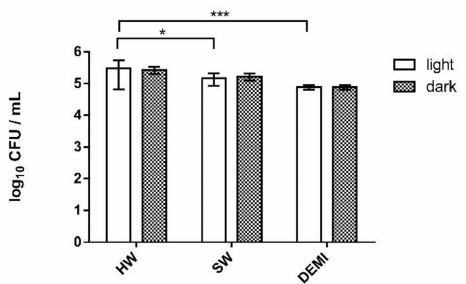
Figure 12. Impact of water hardness (HW, SW, and DEMI) and violet light irradiation on L. pneumophila biofilm. For the light treatments, irradiation with violet light was used for 10 min (395 nm, total light dose 12 J/ cm 2 ). Results are presented as an average with SD on error bars; *** 0.0001 < p < 0.001, * 0.01 < p <